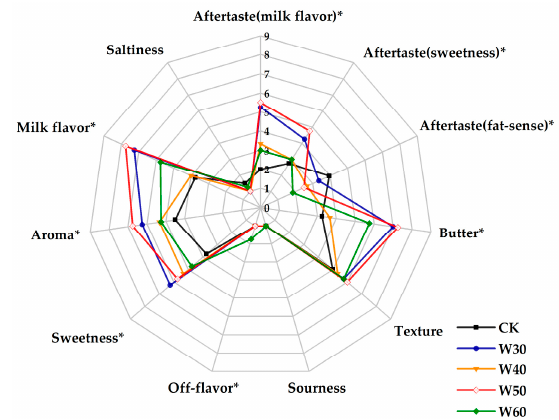
Figure 1. Sensory evaluation of the skim milk samples preheated at different temperature.